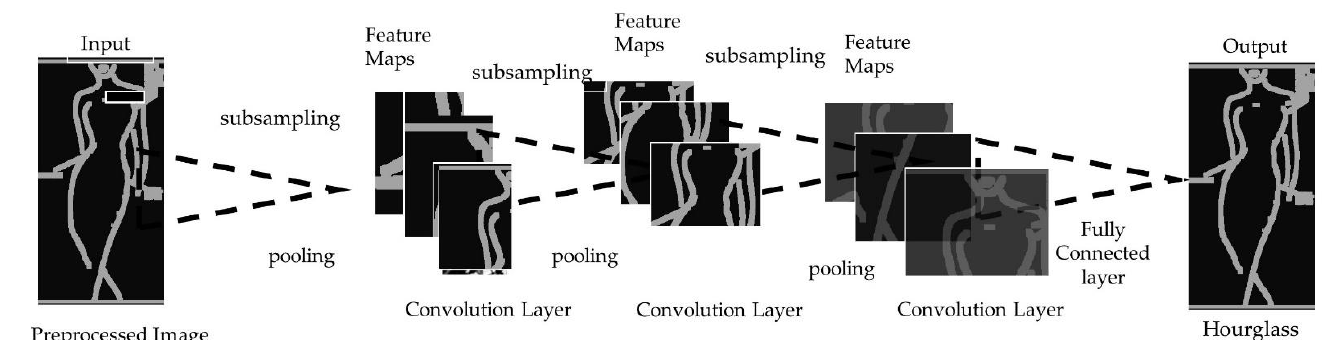
Figure 14. The convolutional neural network for body shape detection. The convolution layers are obtained by subsampling and pooling, and the fully connected layer classifies the input image.